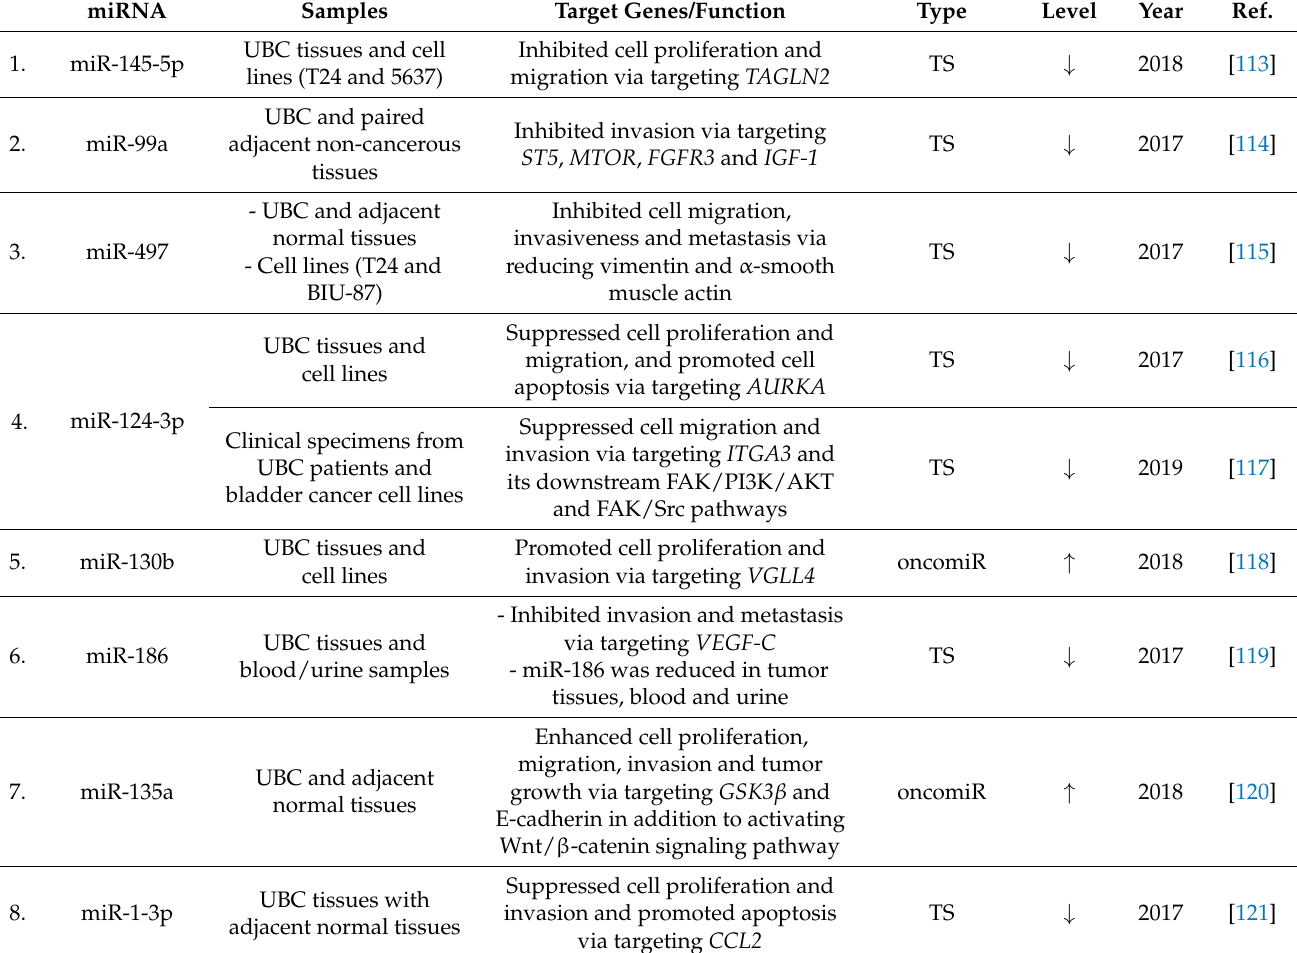
Table 4. miRNAs acting as oncomiRs or tumor suppressor genes in addition to their biological roles and possible targets in urinary bladder cancer. miRNAs are arranged numerically based on being most relevant and frequently attributed in the